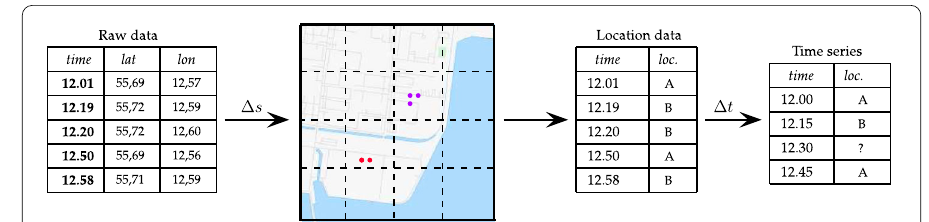
. After filtering we i